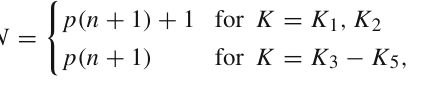
spectrum of the model defined by Eqs. (8) and (10) for K = K 1 − K 5 along the path in Eq. (12)